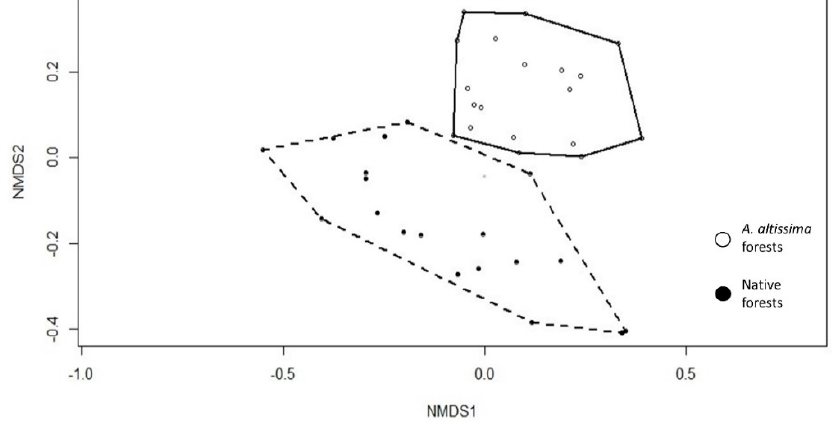
Figure 1. Nonmetric multidimensional scaling (NMDS) ordination diagram (axes NMDS1 and NMDS2) of the A. altissima and reference forest plots. The stress value of the ordination is 0.15.